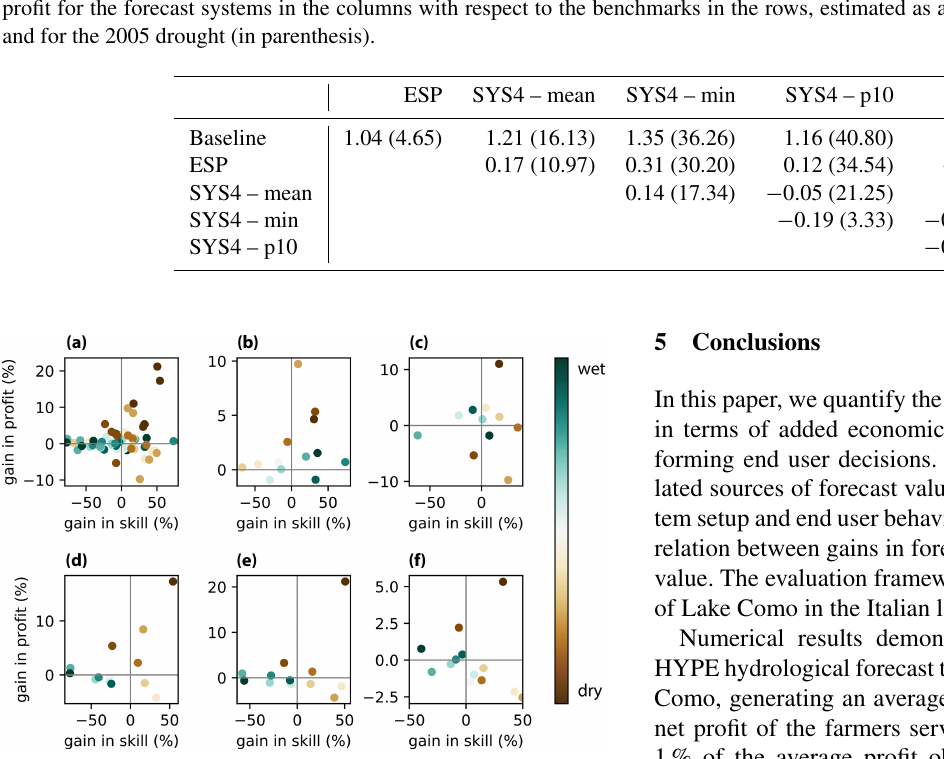
Figure 6. Scatterplot between forecast skill and value. The color of the circles represents the hydrologic conditions (i.e., annual inflow to the lake) of the different years. Markers represent either an iso- lated component of the forecast system or a behavioral factor for each year over the 1996–2008 time period: all components (a) , ESP vs. baseline (b) , SYS4 – mean vs. ESP (c) , SYS4 – min vs. SYS4 – mean (d) , SYS4 – p10 vs. SYS4 – mean (e) , and SYS4 – p25 vs. SYS4 – mean (f)